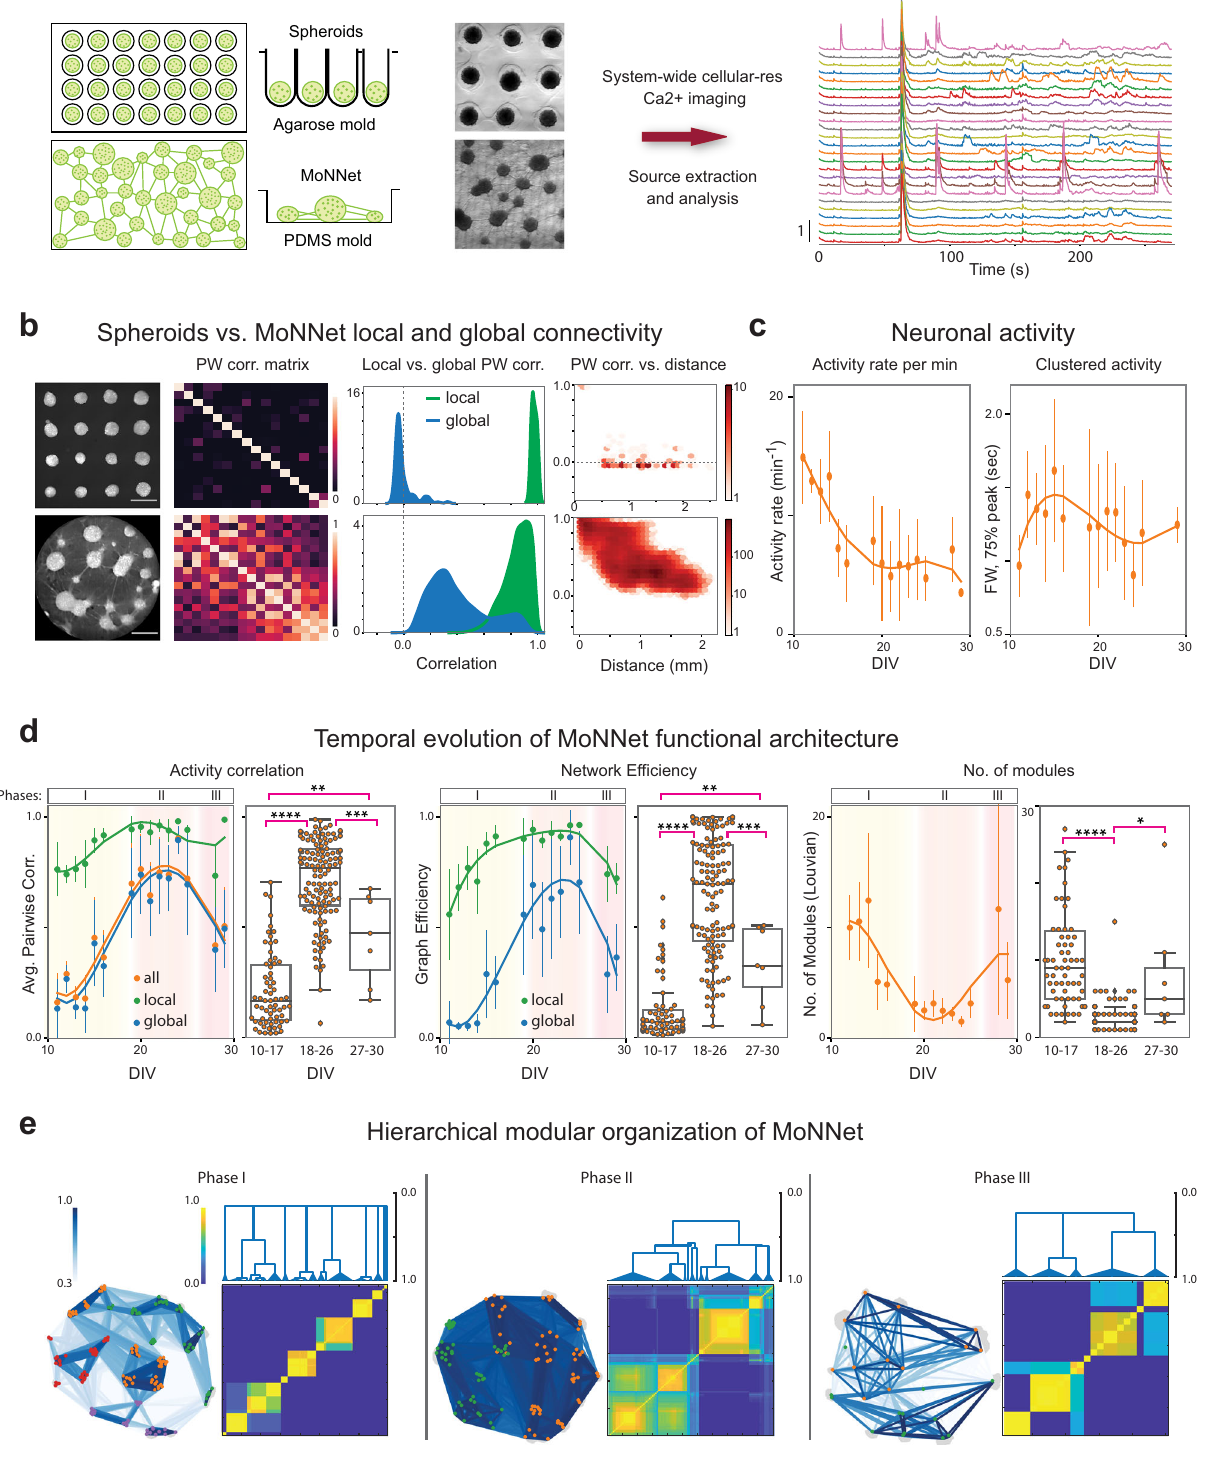
(~4.5 min, 30 Hz) of these preparations for capturing system-wide Ca 2 + signaling as a proxy for neuronal activities (imaging details described in “ Methods ”